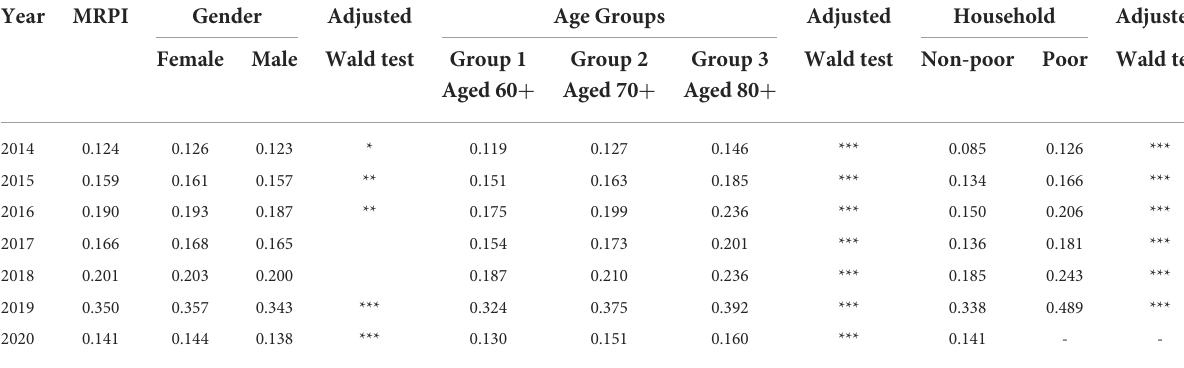
TABLE 3 The MRPI for rural older adults from 2014 to 2020 and group difference. MRPI Gender Adjusted Age Groups